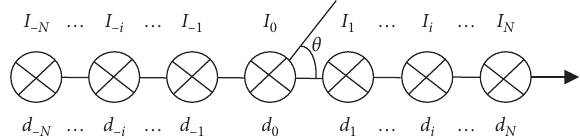
Figure 1: Geometry of the nonuniformly linear symmetric